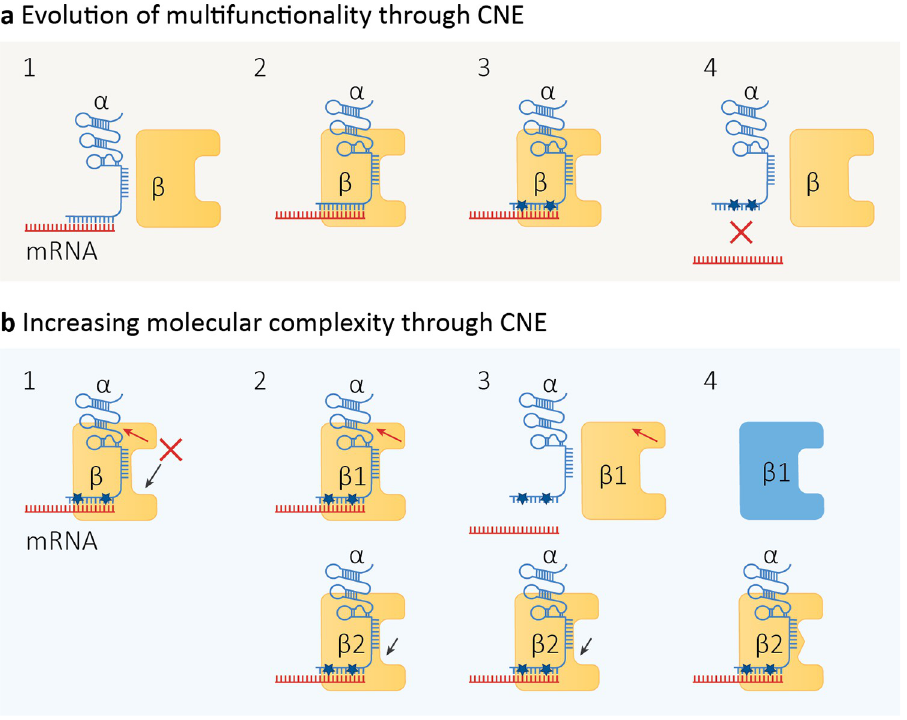
Fig 2. General examples of CNE. ( a ) Multifunctionality evolution through CNE. (1) α is a generic noncoding RNA that mediates RNA silencing on its target mRNA (red), and β is an enzyme that participates in cellular metabolism. (2) By chance, α and β may interact in the cellular environment creating an ephemeral complex. (3) Excess capacity in β results in the stabilization of the α –mRNA complex and then exerts a suppressive effect on mutations in α , which are now no longer deleterious [19,114].(4) At this stage, α is reliant on interaction with β to exert its activity, while β has gained a new function in becoming a chaperone for α . ( b ) Increasing molecular complexity by CNE. (1) Mutations that inhibit the catalytic function of β (black arrow) or compromise α – β interactions (red arrow) are dangerous for the organism and would be eliminated by purifying selection. (2) In the case of gene duplication of β (represented by β 1 and β 2), there is now an excess capacity in the system that can exert a presuppressive activity [19,113].(3) Mutations that compromise the stability of α – β interactions in β 1 and the enzymatic activity in β 2 are no longer deleterious since that function can be carried out by the other protein. (4) β 1 and β 2 can now evolve as 2 different proteins, without adaptive evolution. CNE, constructive neutral